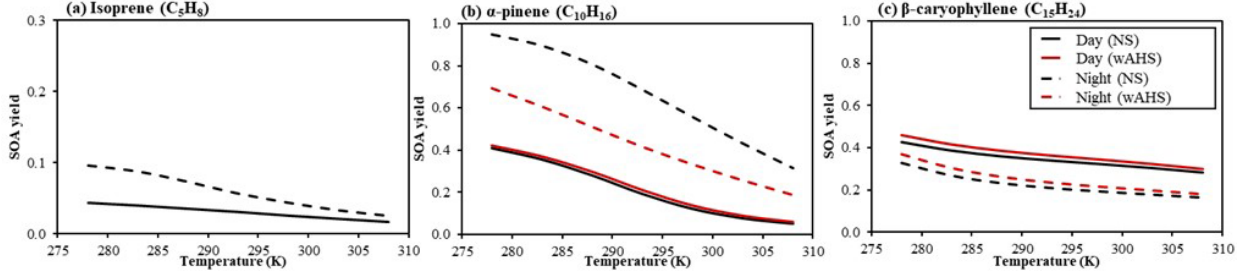
Figure 5. The biogenic SOA yield from (a) isoprene, (b) α -pinene, and (c) β -caryophyllene in both daytime (solid line) and nighttime (dashed line) under the various temperatures, ranging from 278 to 308K. The HC / NO x level was set to 3ppbCppb − 1 . The SOA formation was simulated with 10µgm − 3 of OM 0 at the 50% of RH with the fixed initial concentration of isoprene, α -pinene, and β -caryophyllene at 50, 30, and 24ppb, respectively. The sensitivity of SOA mass to temperature is investigated by simulating α -pinene and β -caryophyllene under NS and wAHS (20µgm − 3 ) conditions. The daytime SOA formation was simulated under the reference sunlight intensity (Fig. S1), which was measured on 19 June 2015 at the UF-APHOR. For the nighttime simulation, the initial O 3 concentration was set to 30ppb. The wall-free model parameters were applied to simulate SOA formation (Han and Jang,